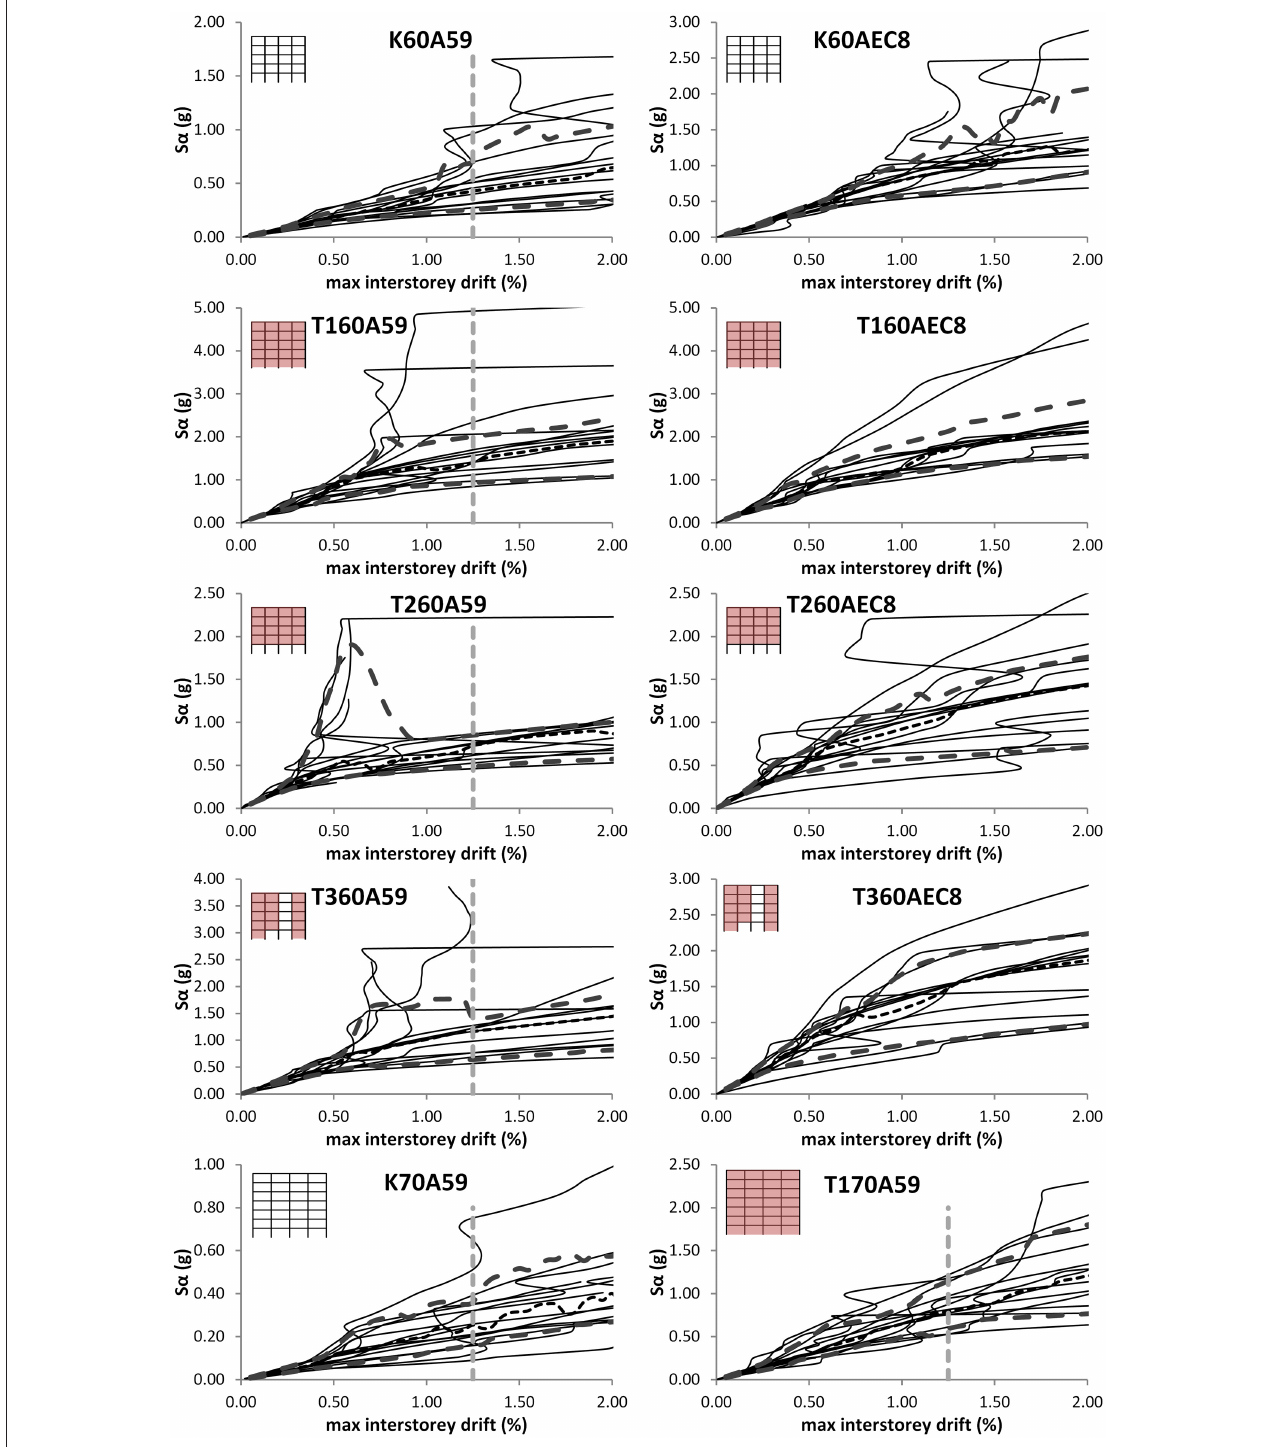
FIGURE 7 | IDA curves for the bare and infill frames considered: median, 16 and 84% fractiles for all 14 records considered. frames. Due to the interaction between the RC frame and the inclusion of the infills results in a considerable increase in the infills the shear strength of columns is surpassed earlier than the initial stiffness, while also, the maximum displacement at failure bare frame structures, with this LC, however, not being critical, of the infilled structures is decreased compared to the bare